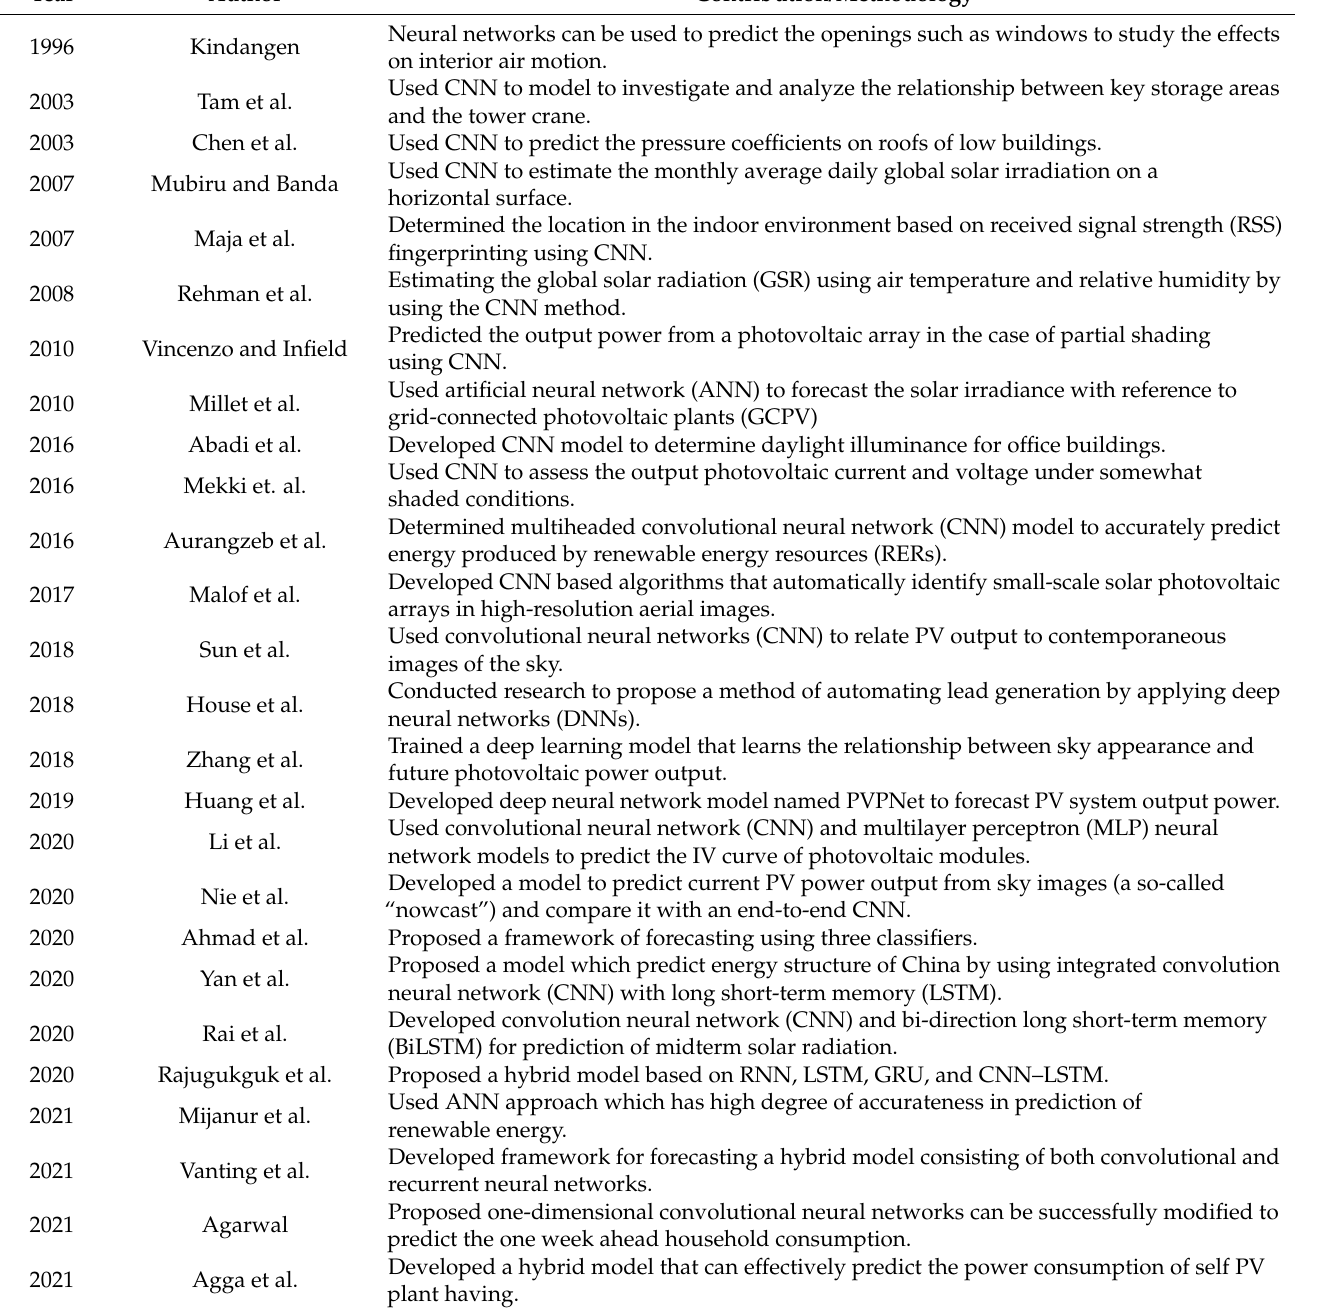
Table 1. Summary of literature